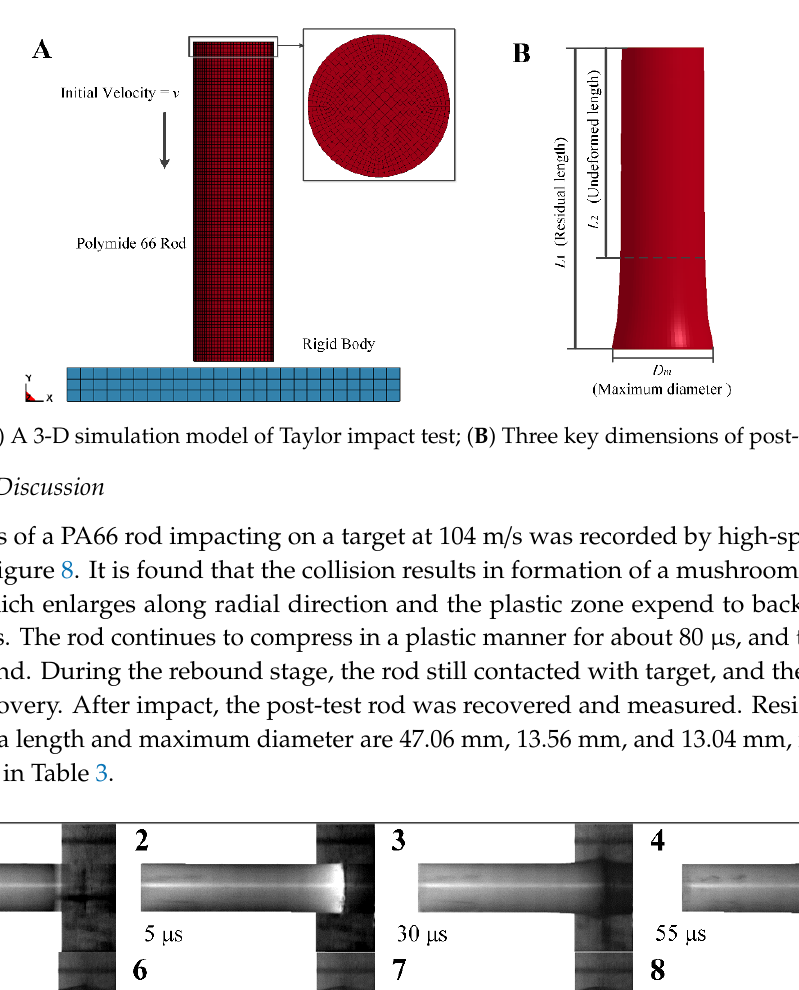
Figure 8. High-speed photographs of Taylor impact test at 104 m/s.